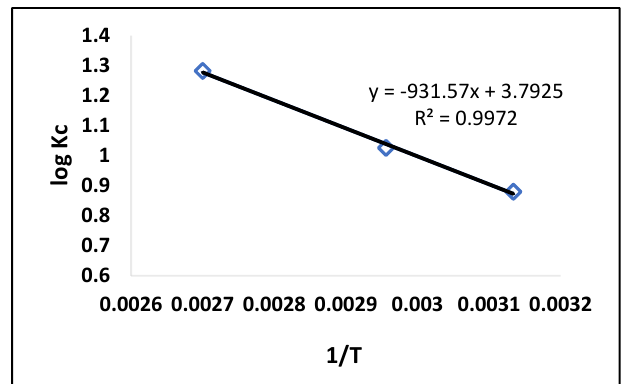
Figure 8. Van’t Hoff graph (MIP) . Table 4. Different thermodynamic parameters for AB-234 dye.